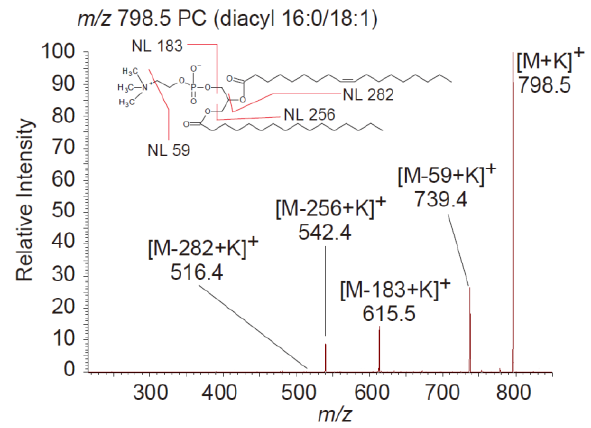
Figure 3. Phosphatidylcholine (PC) MS/MS spectrum at m/z 798.5. Neutral loss of the PC head group and fatty acids is generally observed by MS/MS analysis of phospholipids in tissues.